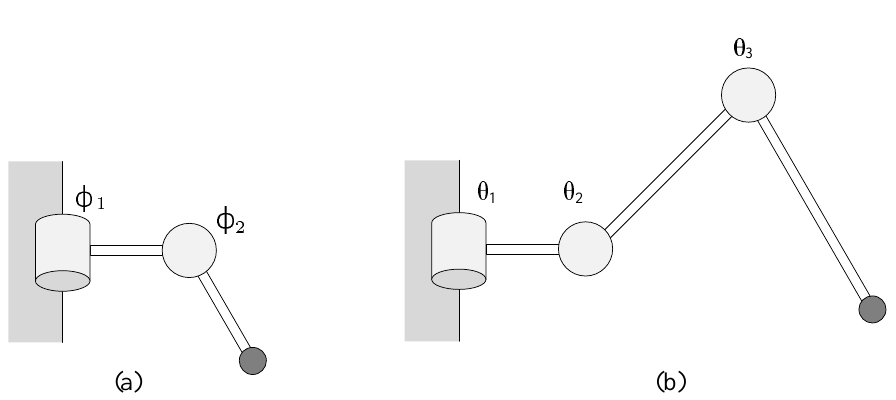
Figure 11. The model of mudskipper’s fin and quadruped robot: ( a ) 2-DOFs mudskipper fin; ( b ) robot used in present study.